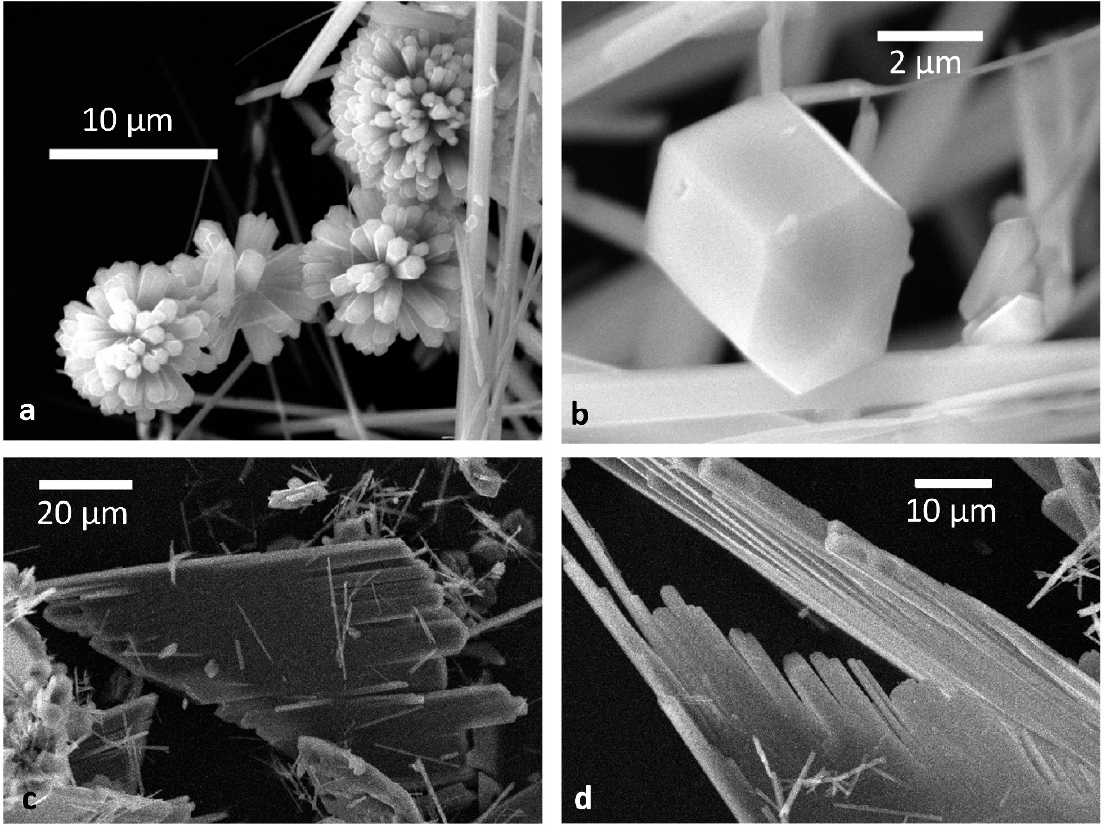
Figure 2. ( a,b ) Hydroxyapatite grown from a monetite/water suspension at 210 °C and autogenic pressure in the presence of citric acid; ( c,d ) hydroxyapatite grown from the same suspension as in ( a,b ), but at 135 °C. It is worth outlining that the lengths of the individuals building the fence ‐ like aggregate progressively decrease, indicating different nucleation times during the growth